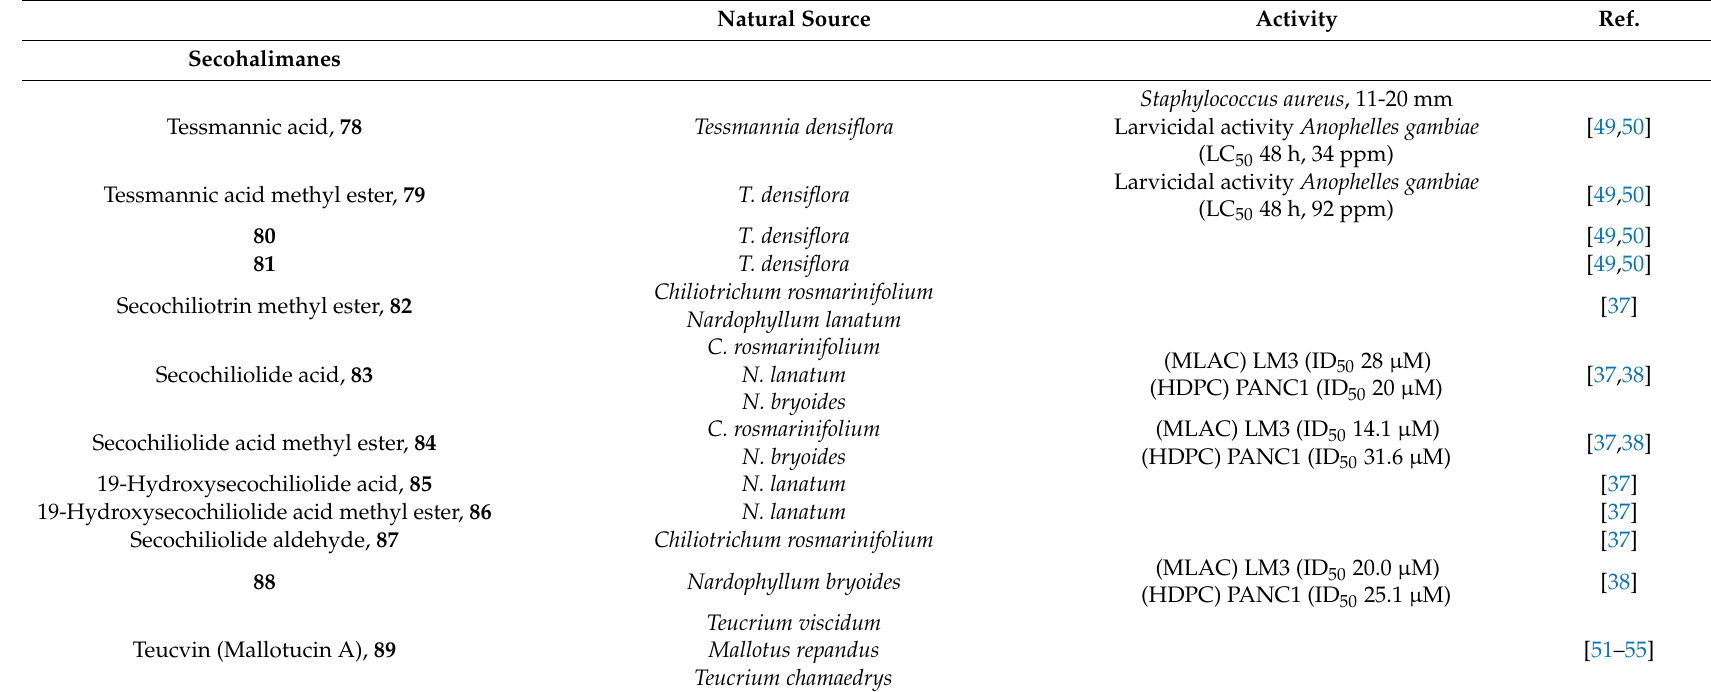
Table 3. Secohalimanes and